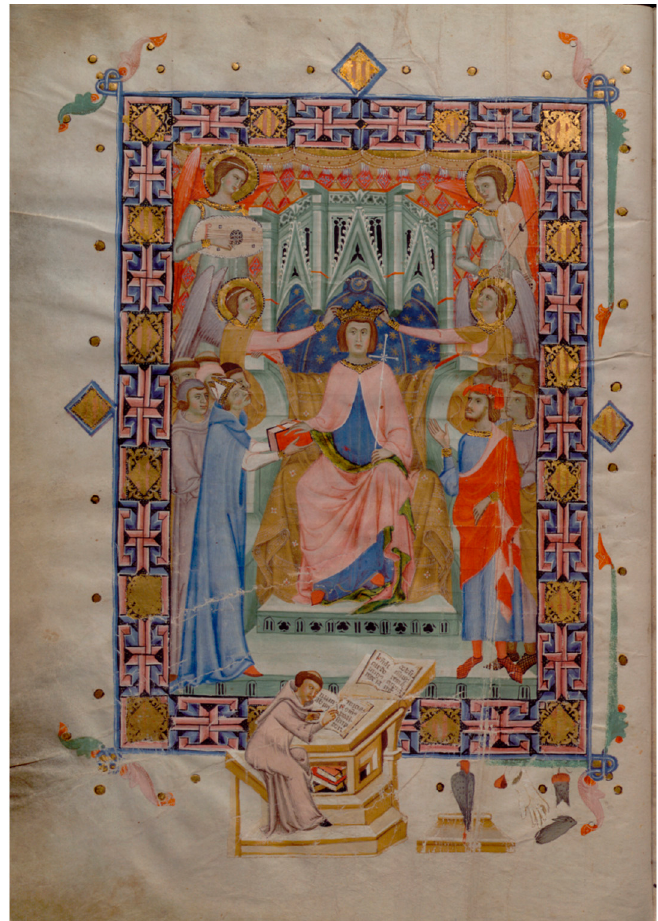
Figure 3. Llibre de franqueses i privilegis del Regne de Mallorca. Mallorca, Arxiu del Regne de Mallorca, codex 1, f. 13v.Used by permission.